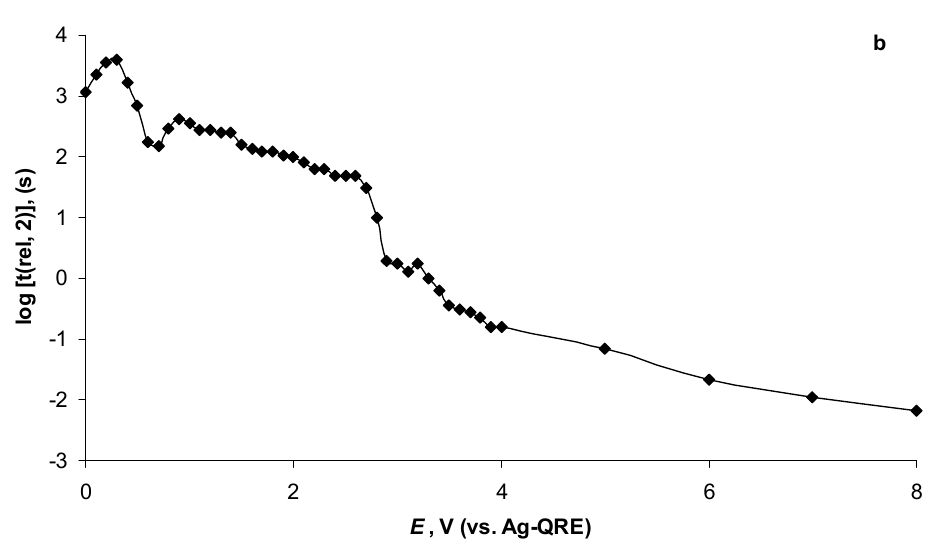
Figure 11. Mid-frequency relaxation time constant (log [t(rel, 1)]) vs. E ( a ) and low-frequency relaxation time constant (log [t(rel, 2)]) vs. E relationships ( b ). The values of t(rel, 2), estimated graphically from P(w)/S(w) vs. log ν and Q(w)/S(w) vs. log ν plots measured at low potentials applied, were unstable, probably because of difficulties in their precise estimation from the graphs at E ≤ 0.60 V. However, the esti- mated values of t(rel, 2) seemed to increase from the initial value (t(rel, 2) = 1200 s, E = 0.00 V), as the Al/Al 2 O 3 electrode potential was changed stepwise to be more positive, forming a maximum t(rel, 2) = 4000 s at E = 0.30 V (Figure 11b). Thereafter, a steep reduction in log [t(rel, 2)] values was observed, showing a minimum at E = 0.60 V and E = 0.70 V. At more